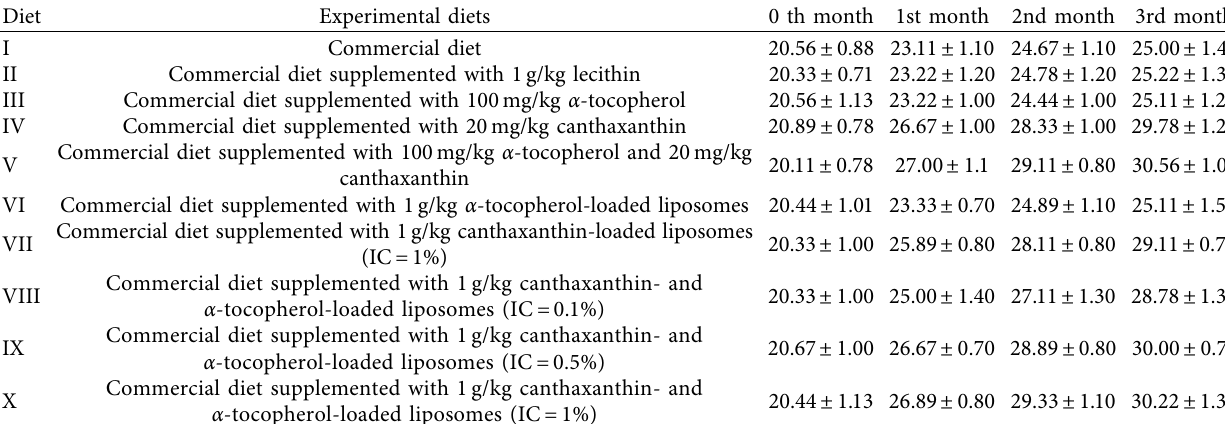
Table 5: Color scores of fillets taken from rainbow trout treated with different formulated diets at the initial time point and after one, two, and three months of experimental feeding ( n � 3